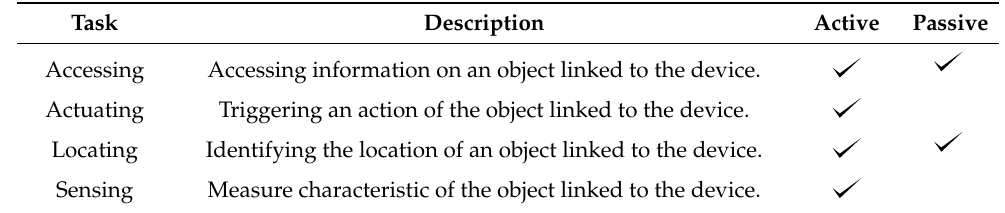
Table 2. Task Classification for Active and Passive Devices. Task Description Active Passive